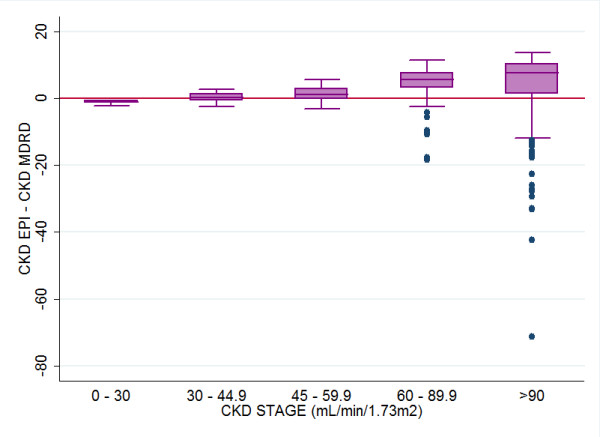
Comparison of eGFR calculated by CKD-EPI and MDRD equations (CKD-EPI − MDRD) using a box plot with non parametric IQR and range across each eGFR stage, illustrating line of agreement at CKD-EPI − MDRD=0.